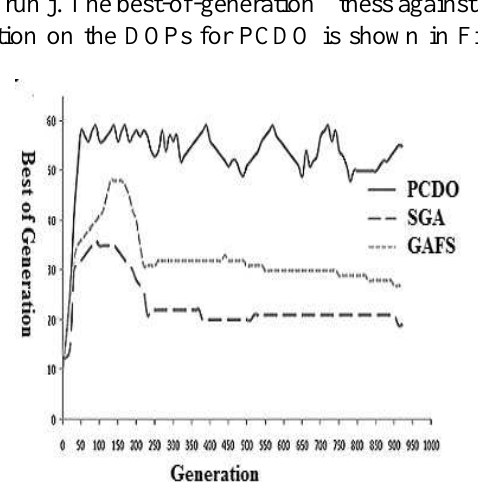
Fig. 2. Dynamic performance of PCDO compared to SGA and GAFS